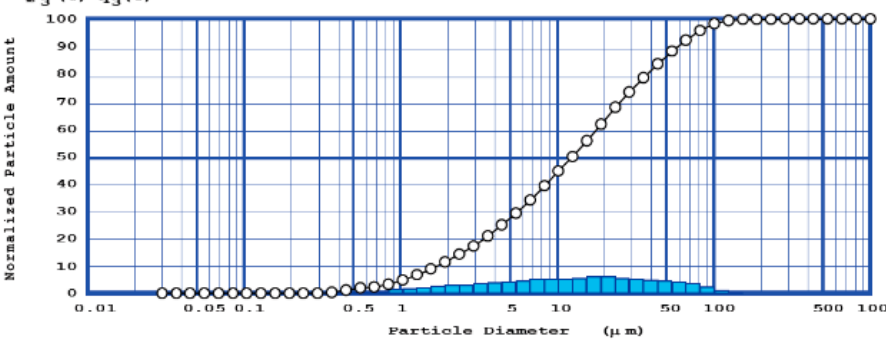
Figure 3. Grain size distribution of waste granite powder obtained by laser diffraction.